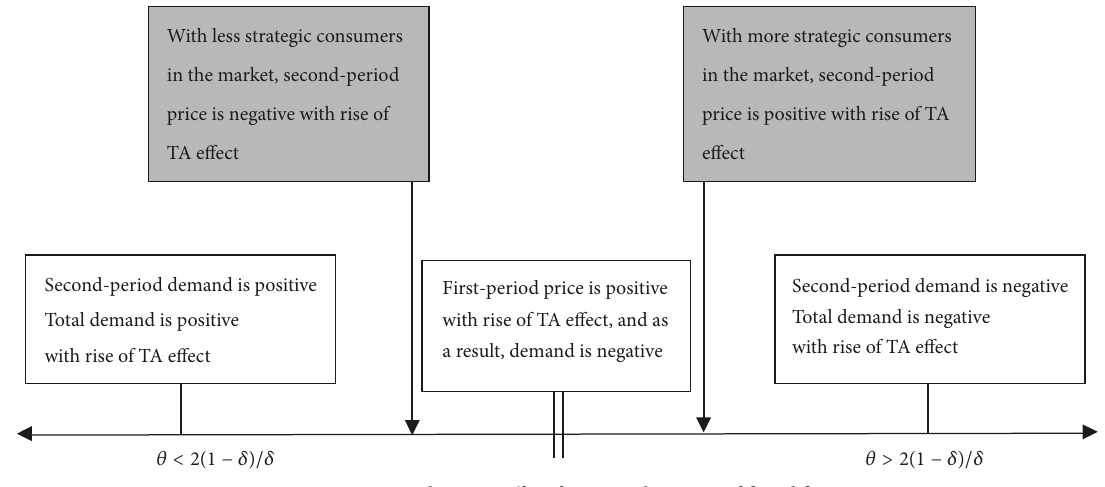
Figure 3: Moderation effect from combination of 𝜃 and 𝛿